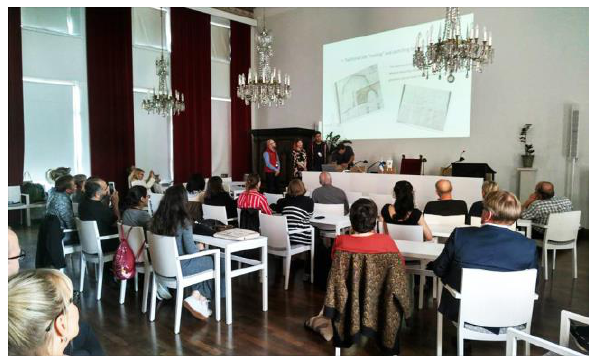
Figure 15. Presentation of results at the Hamina City Hall